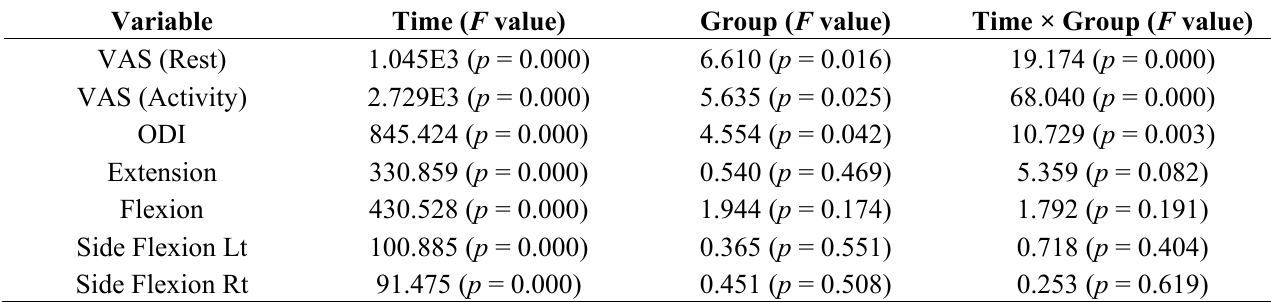
Table 2. ANOVA results testing for effects of